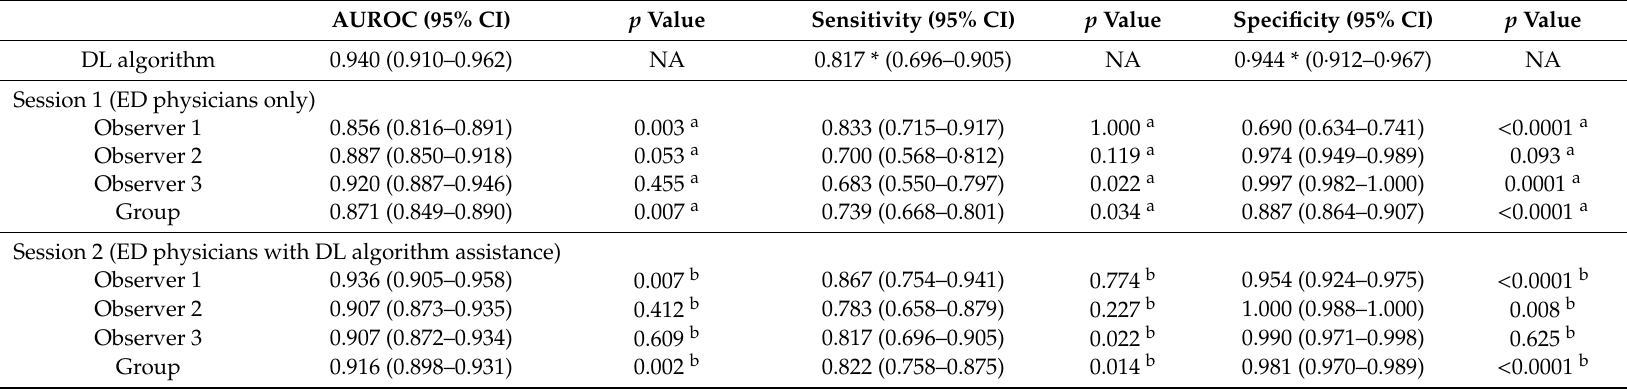
Table 3. Diagnostic Performance of DL algorithm and ED physicians (visible pneumonia on CR vs.